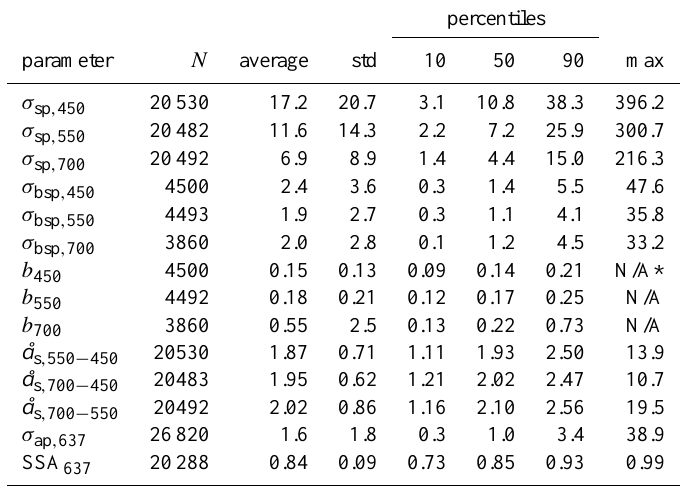
Table 1. Number ( N ), average, standard deviation (std), 10th, 50th, and 90th percentiles, and maxima (max) of valid observations for aerosol scattering and backscattering coefficients at 450, 550, and 700 nm ( σ sp , 450 , σ bsp , 450 , σ sp , 550 , σ bsp , 550 , σ sp , 700 , and σ bsp , 700 in Mm − 1 ) , hemispheric backscattering fractions at 450, 550, and 700nm ( b 450 , b 550 , and b 700 ) , ˚Angstr¨om exponents between 550 and 450nm, 700